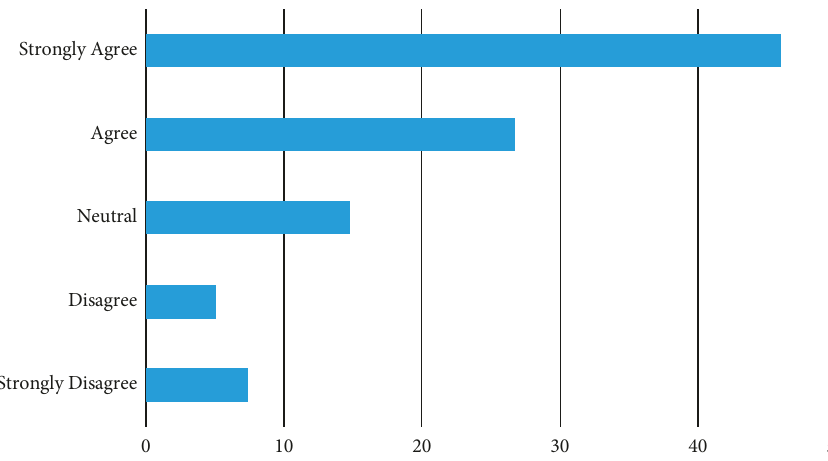
Figure 1: Better protection of data.